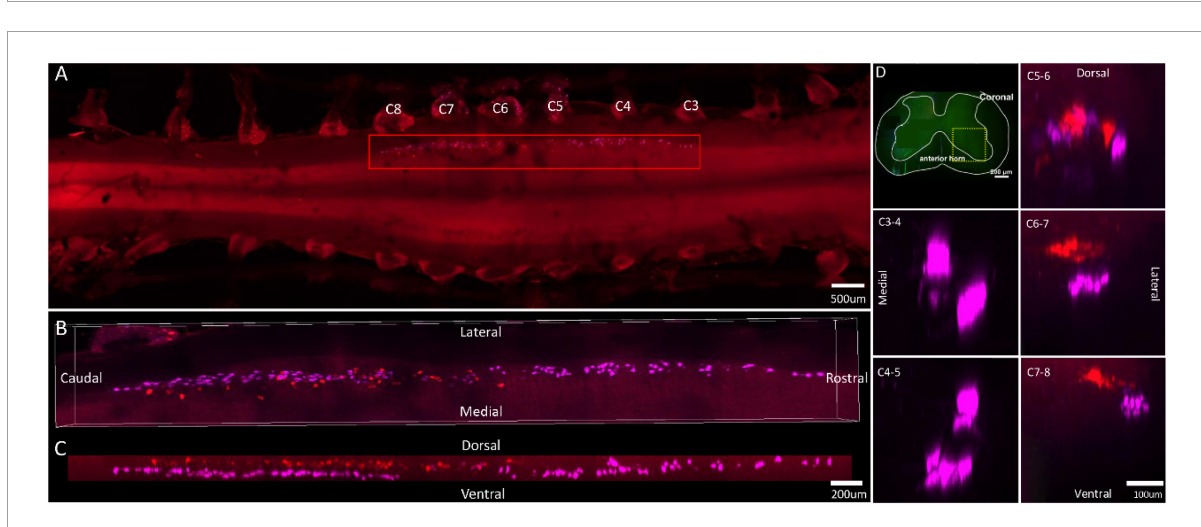
FIGURE4 Distribution characteristics of motor neurons targeting triceps (labeled by FG, red), and extensor digitorum communis (labeled by CTb-647, purple). (A) Spatial images of multi-tracks in a holistic view. (B,C) The relative spatial positions of the motor neuron columns targeting different muscles in sagittal and corona viewing angles. (D) The schematic diagram of the distribution of different motor neuron columns in the anterior horn of the spinal cord. The yellow box that outlines the region of interest is amplified in the subpanels in panel (D) . The cross-sectional images are maximum projections of different parts of the spinal cord. The motor neurons innervating triceps have little overlapping with extensor digitorum